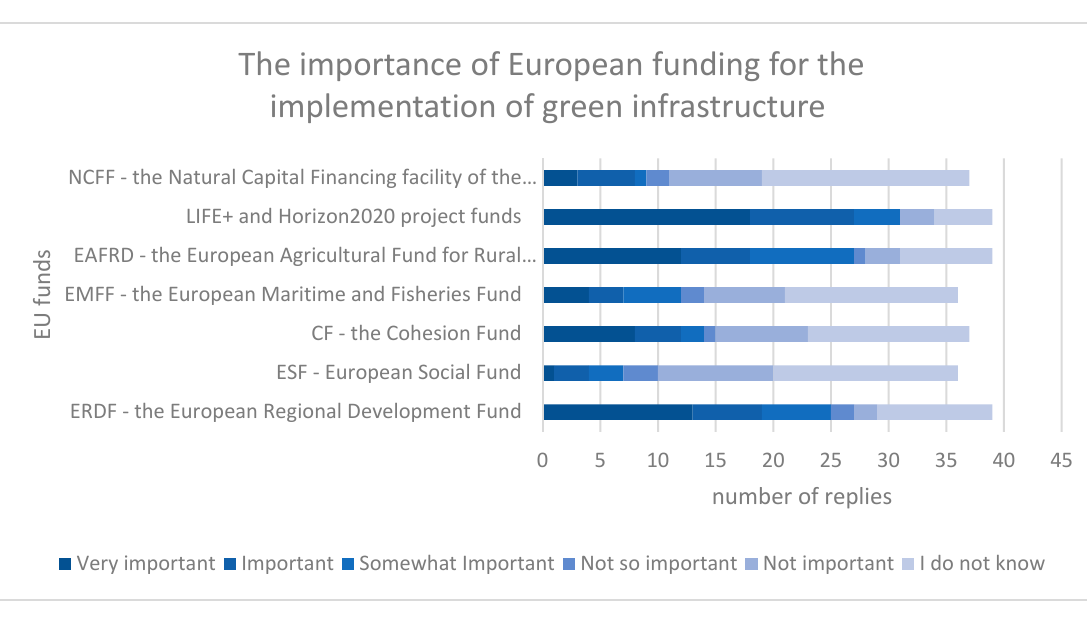
Figure 4. The importance of European funding for the implementation of green infrastructure in 32 European countries (EU28 and Iceland, Liechtenstein, Norway and Switzerland) based on a summary of 40 online survey responses to the question.